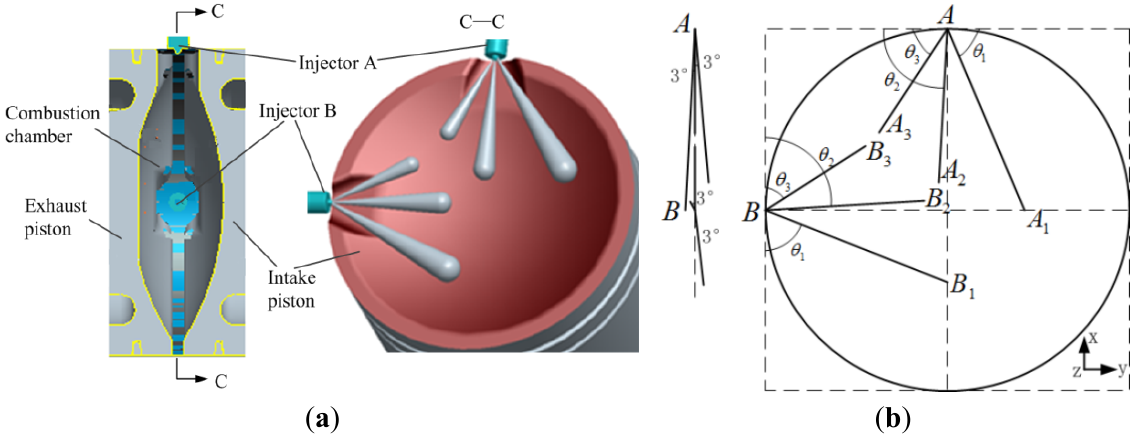
Figure 2. ( a ) OPFC diesel engine combustion chamber and injector position; ( b ) injector spraying direction.